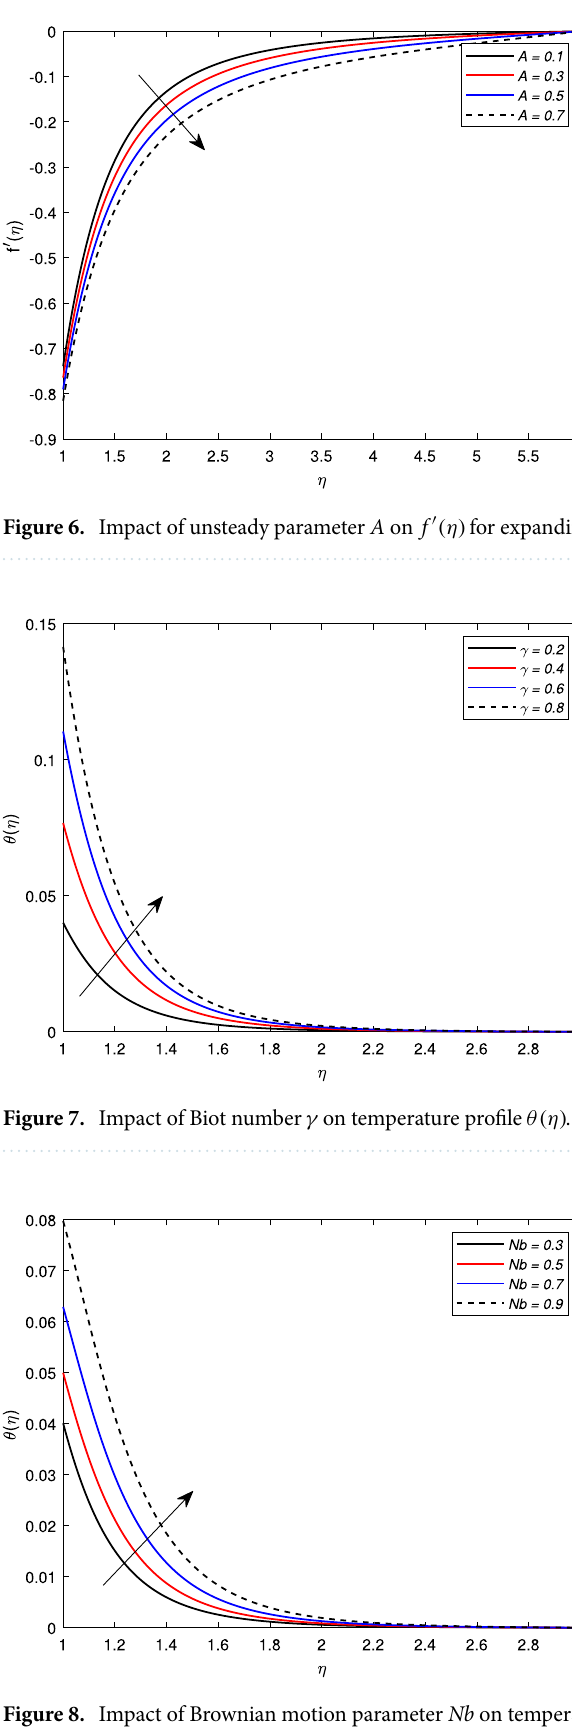
Figure 8. Impact of Brownian motion parameter Nb on temperature profile θ(η) .